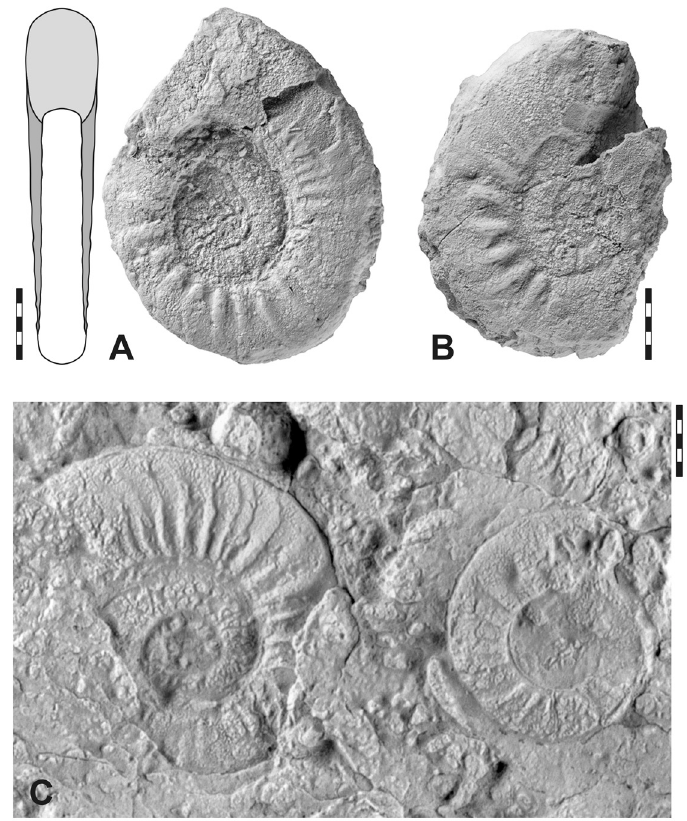
Fig. 21. Arasella falcata Korn & Hairapetian sp. nov. A . Lateral and dorsal view, holotype MB.C.29734, section C, -0.05 m. B . Lateral view, paratype MB.C.29733, section 1, -0.05 m. C . Lateral views, paratype MB.C.29736, section H, -0.05 m. Scale bar units = 1